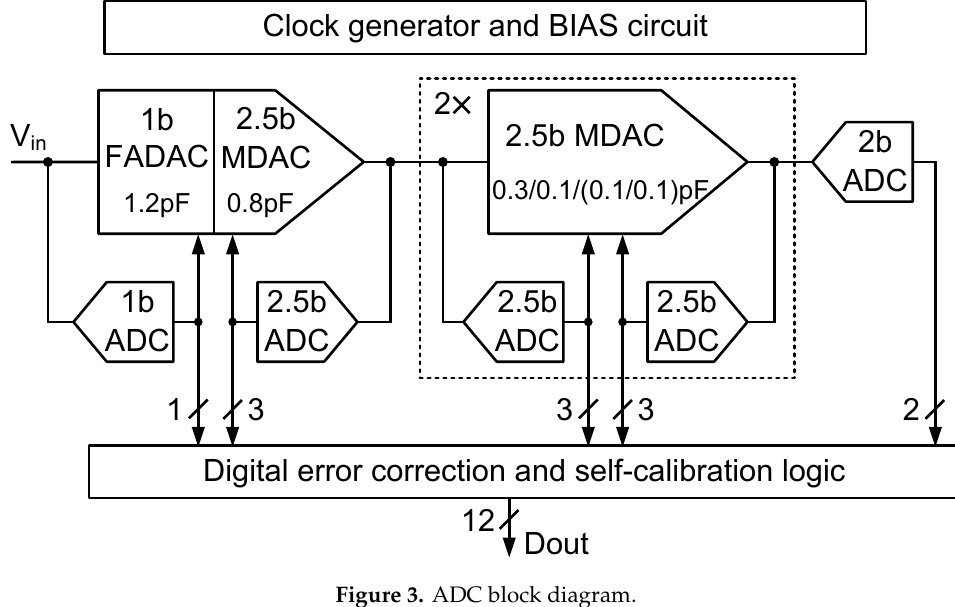
Figure 3. ADC block diagram.